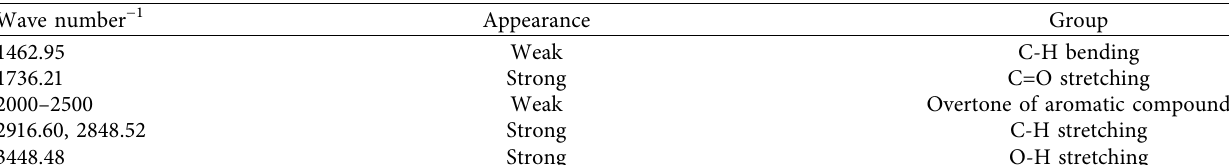
Figure 1: The spectrum represents the peak of stingless bees wax. Table 2: FTIR characteristic peaks of stingless bee wax.